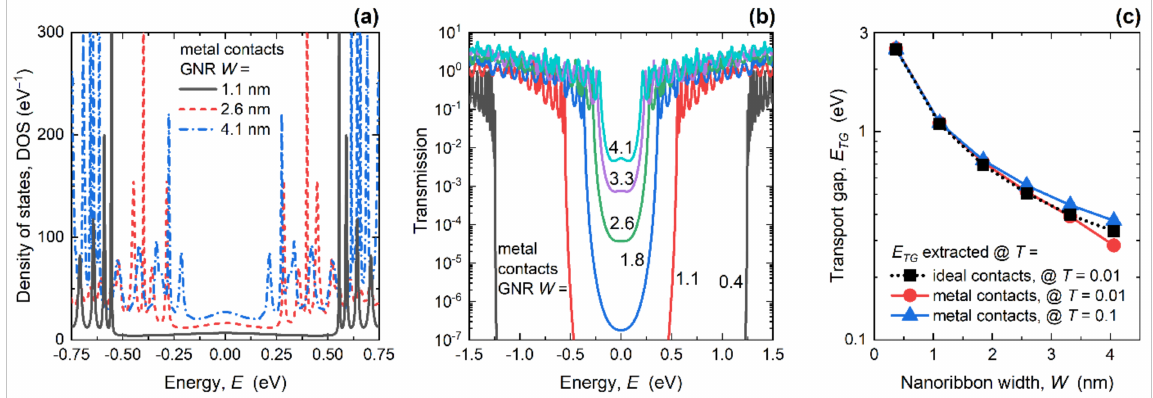
Figure 2. ( a ) Density of states in GNRs with MCs, for various widths; ( b ) impact of width scaling on the transmission of GNRs with MCs; ( c ) band and transport gaps in GNRs with ICs and MCs, respectively. In all cases, L = 15.2